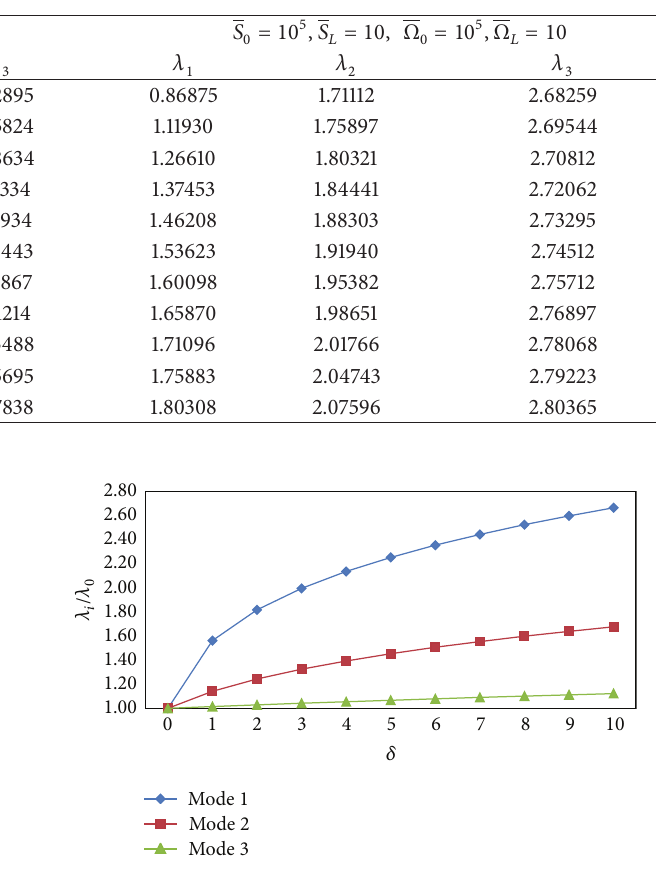
Figure 6: Effect of elastic foundation parameter on the vibration frequencies for 𝑆 0 = 10 , 𝑆 𝐿 = 10 , Ω 0 = 10 5 , and Ω 𝐿 = 10 5